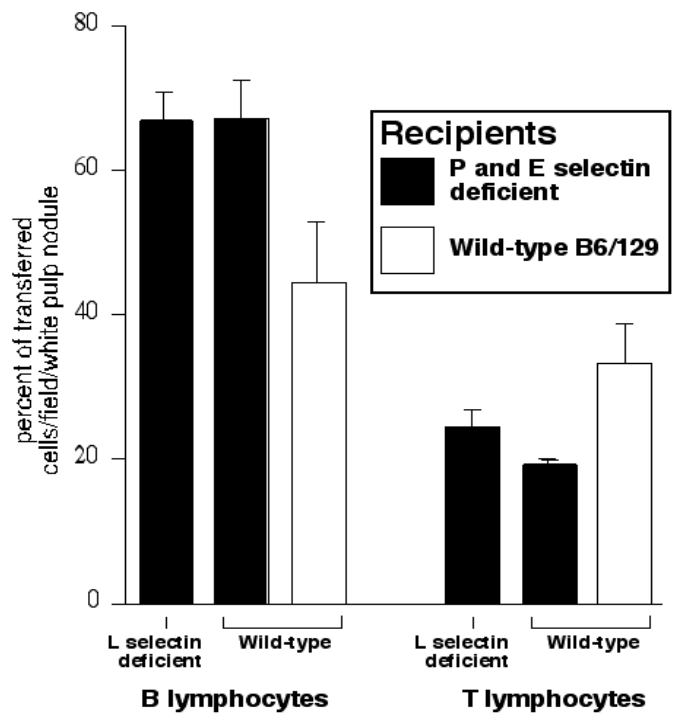
FIGURE 5. Accumulation of T and B lymphocytes in the lymphoid compartment of the spleen does not depend upon L-, E-, or P-selectin. 10 7 fluorescently labeled C57Bl6 ⋅ 129 (B6/129, wild-type) or L-selectin deficient T or B lymphocytes were injected into B6/129 or P- and E-selectin deficient recipients. Spleens were harvested after 90 min for T cells and after 4 h for B cells. The number of transferred cells located within white pulp nodules was determined as in Fig. 3. Regardless of the donor or recipient, there was not a significant difference in the total number of cells (counting those both within and outside the white pulp nodules) found in each 100 ⋅ field for both T and B lymphocytes (data not shown). Note also that there was no significant difference in the accumulation of lymphocytes in the white pulp between the selectindeficient and the wild-type mice. Data are presented as means ± SEM; n > 3 mice per